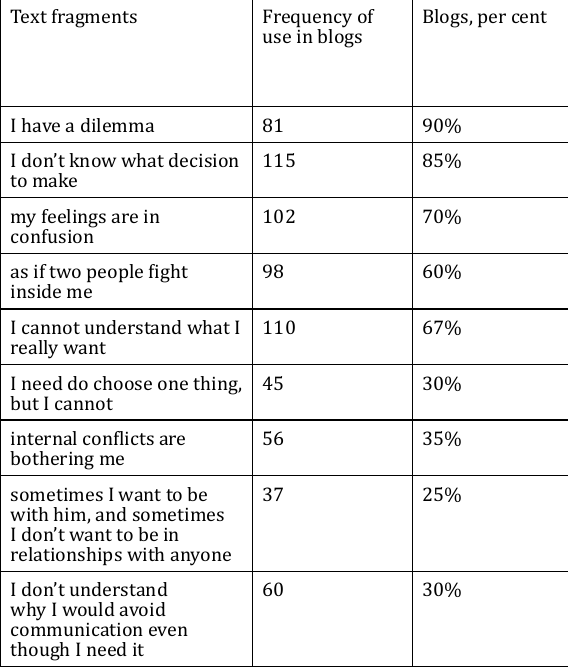
Table 1. Blog text content analysis results